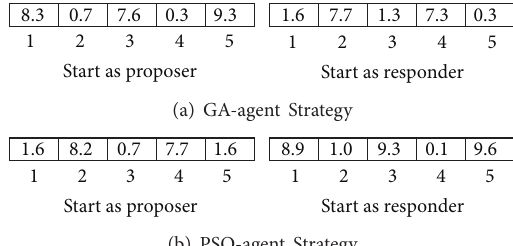
Figure 12: Comparison of strategies after completion of game.